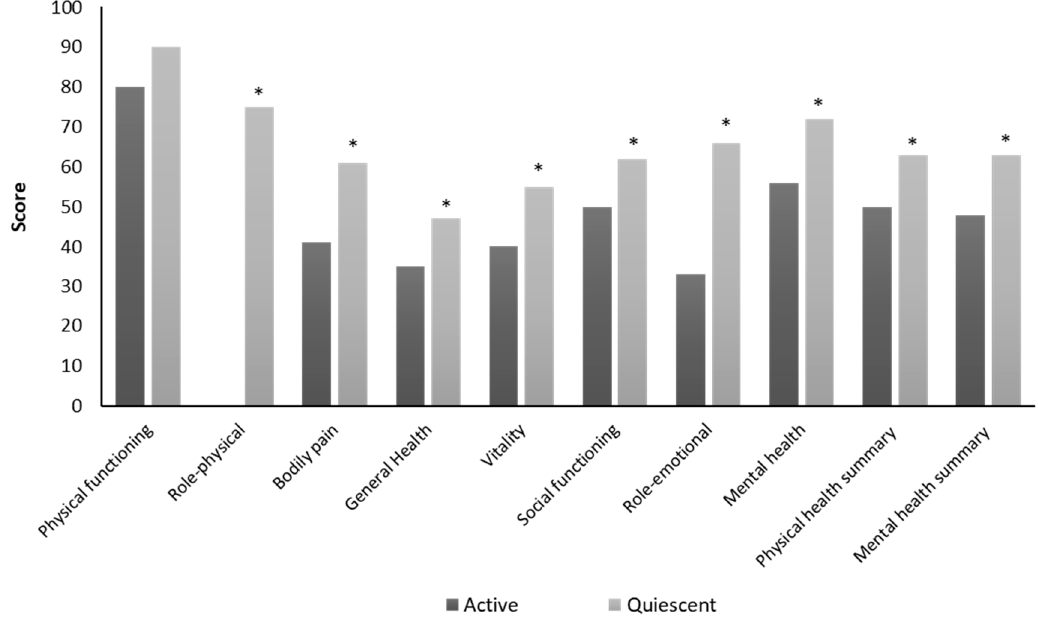
Figure 2. Comparison of health-related quality of life (HRQoL) between the active and the quiescent Crohn’s disease group. * p < 0.05